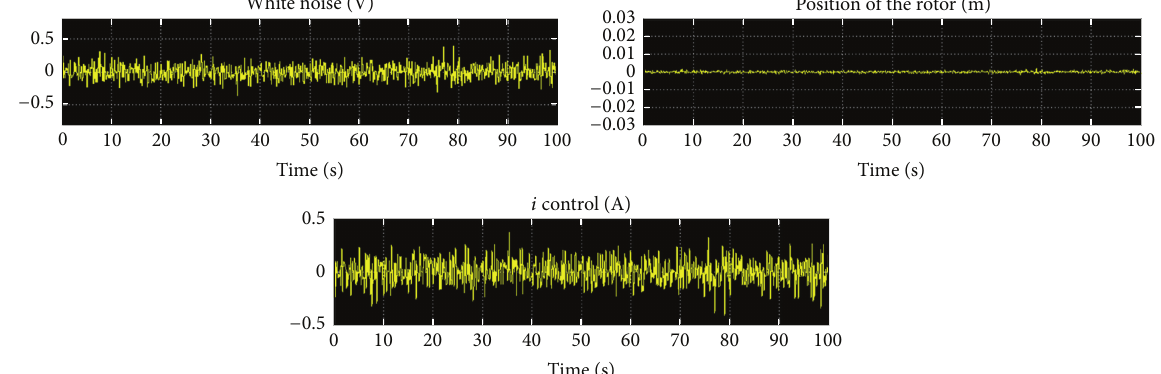
Figure 11: System response with PD controller with proportional gain of 192.8569 and differential gain of 7.8867 and white noise of 0.001 volts.